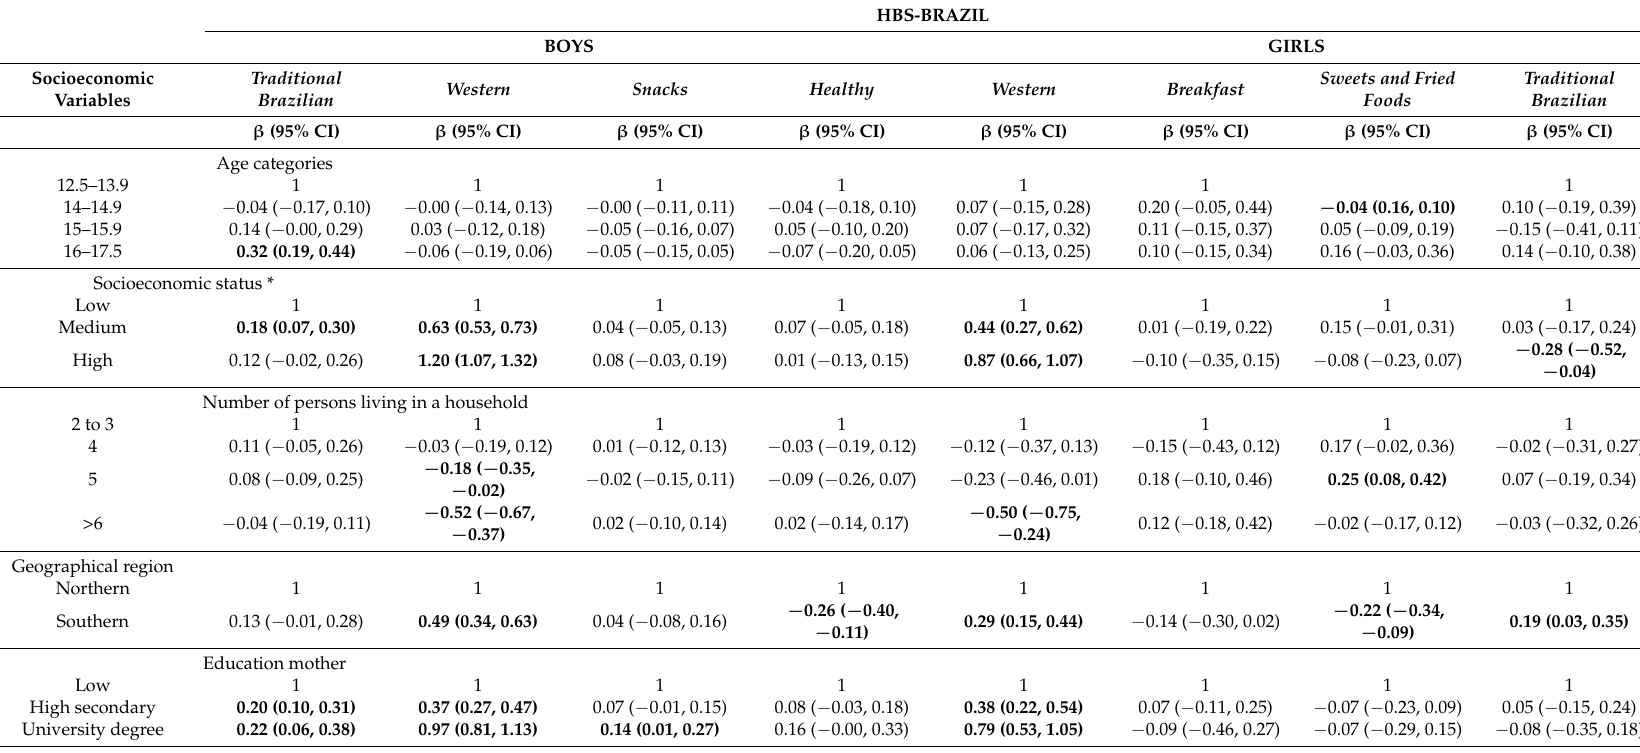
Table 5. Gender specific regression β -coefficients (95% IC) between indicators of socioeconomic status and mean scores of DP in adolescents participating in HBS-Brazil 2008/2009